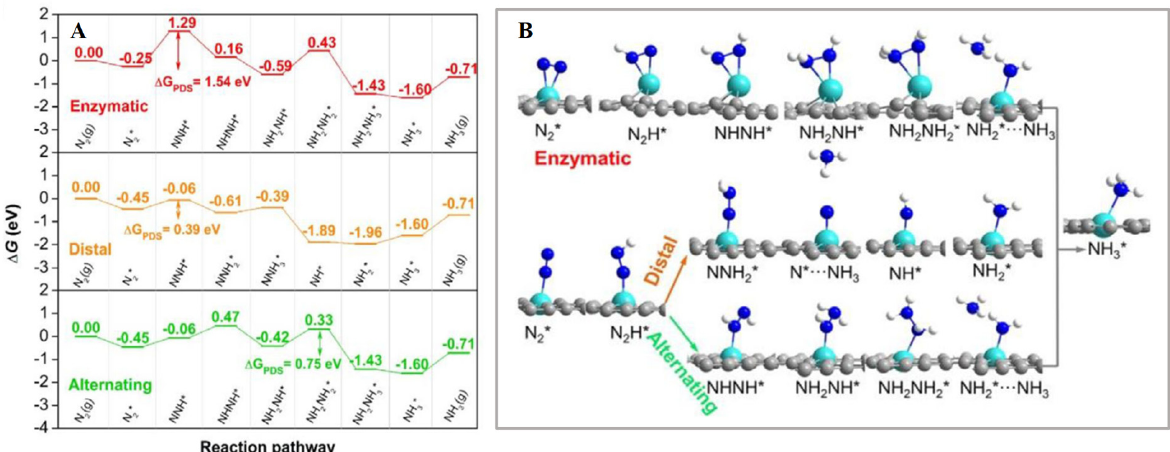
Figure 4. ( A ) The adsorption sites with the distal pathways on Nb ‐ doped GD, shown by Enzymatic free energy diagram for nitrogen electrochemical reduction, Alternating, and Distal pathways on Nb@GD; ( B ) the ammonia conversion by nitrogen [62]. * represents an adsorption site.